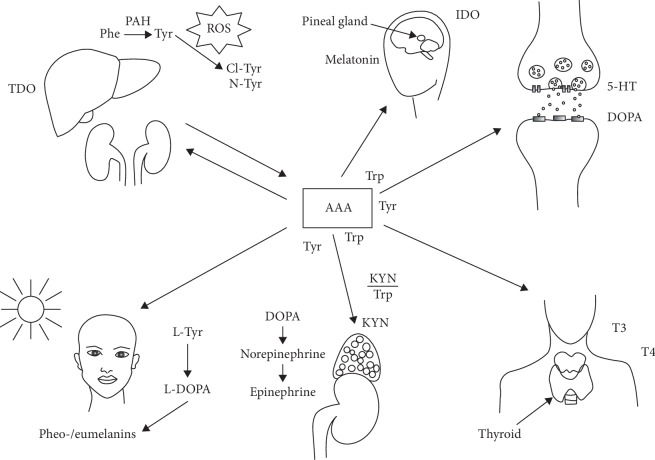
The role of aromatic amino acids (AAA) in the organism and induction of tyrosine derivatives (3,4-dihydroxyphenylalanine (DOPA) and 2,5-dityrosine) by reactive oxygen species. Phenylalanine (Phe) is converted to tyrosine (Tyr) in the liver and kidneys with the participation of phenylalanine hydroxylase (PAH). Tyr is used for the synthesis of catecholamines (dopamine, epinephrine, and norepinephrine) in the adrenal medulla and for the synthesis of pheo- and eumelanins in skin melanocytes, the first stage of which is the formation of L-DOPA. An elevated L-DOPA/L-Tyr ratio occurs in patients with malignant melanoma and local lymph node metastases. Tyr is also the starting compound for the synthesis of thyroid hormones—thyroxine (T4) and tri-iodothyronine (T3). In addition, Tyr derivatives such as 3-Cl-D-Tyr or 3-N-D-Tyr may be formed under oxidative, nitrifying, and chlorinating stress conditions. Tyr catalyzes the reaction that converts Trp to kynurenine (KYN). IDO (indoleamine-2,3-dioxygenase) and TDO (tryptophan-2,3-dioxygenase) are induction enzymes that are activated under stressful situations, among others under the proinflammatory cytokines.